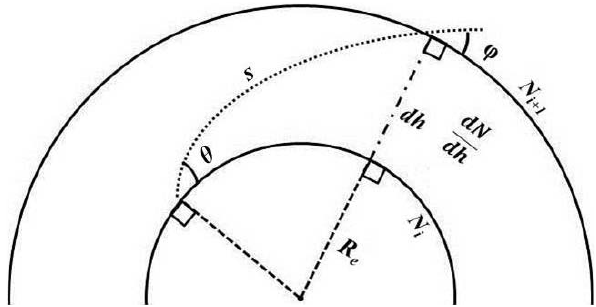
Fig. 1. A sketch showing the propagation at the lowest levels in the atmosphere. The full curved lines represent the 2 first levels of the soundings. On each of these levels is a value of the refractivity of the level N i and N i + 1 that are the refractivity for the first and the second level, respectively. The small dashed lines represent the Earth’s radius ( R e ). The dash dot line represent the height differ- ence between the level (dh). This is also the thickness of the layer between the two model levels. In this layer, there is a value of verti- cal gradient of refractive index (dN/dh). The small dotted line is the path followed by the beam in the propagation with path length ( s ) between the two levels. θ is the elevation angles of the radiometer, and φ is the entrance angle of the next